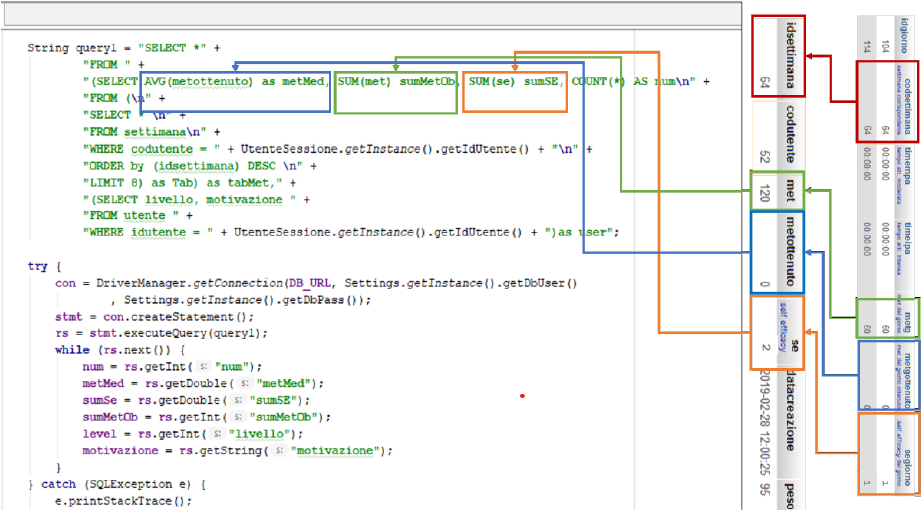
Figure 3. The query is exploited by the UserRating class to extract necessary information from MoveUp